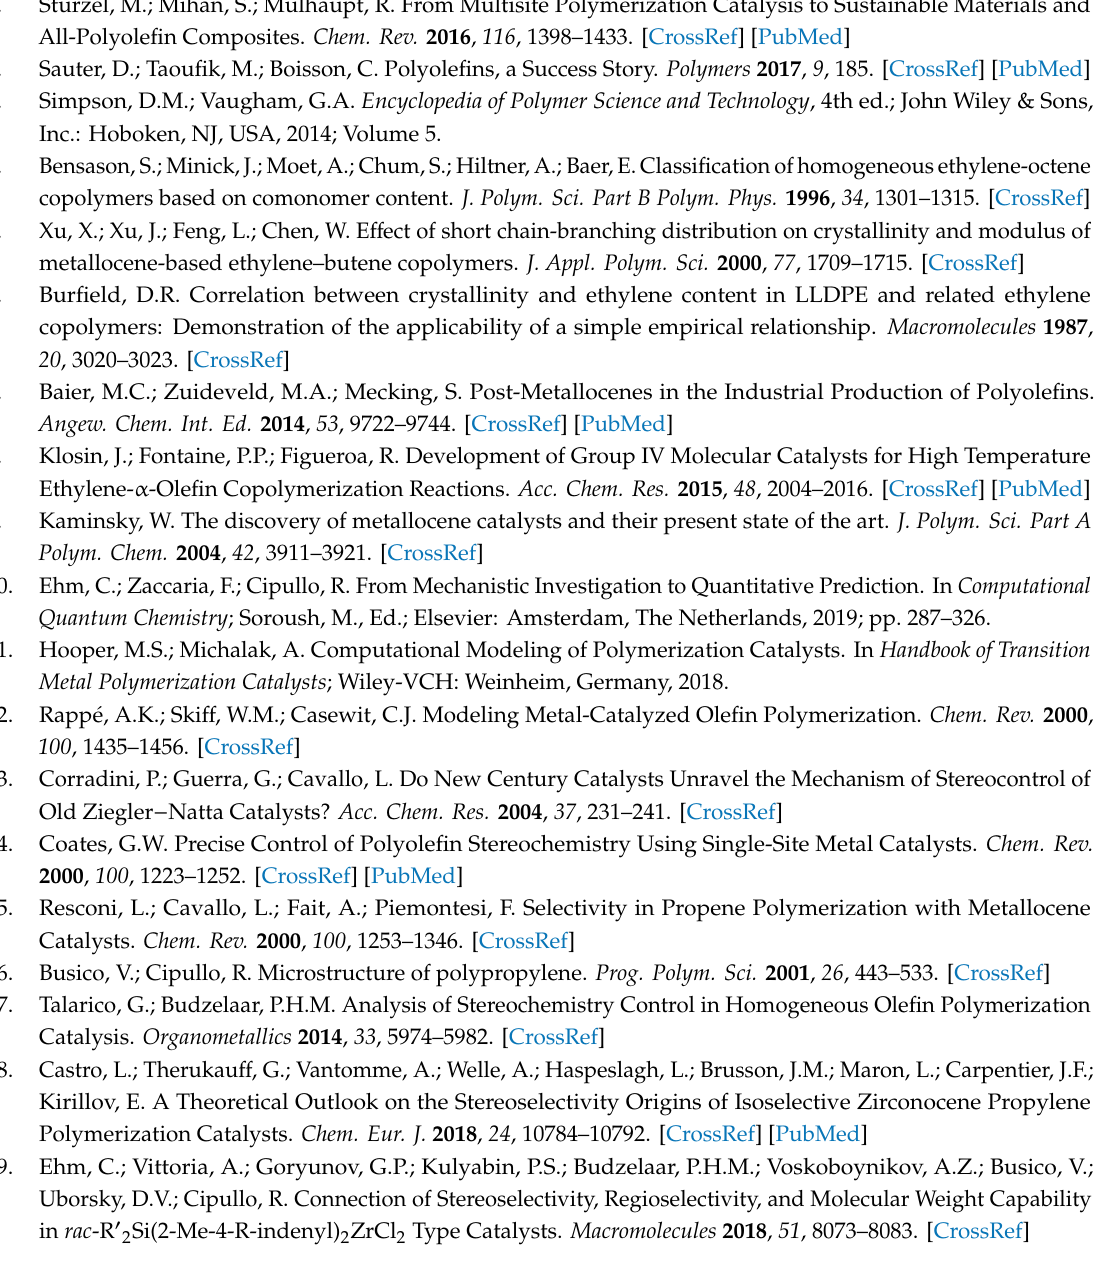
Table S1: Polymerization results, Figure S1: Buried volume analysis, Table S2: Electronic charges, Figure S2: Calculated reaction profiles for propene enchainment after ethene, Table S3: Final energies, entropy, and enthalpy corrections in Hartree, Full Gaussian